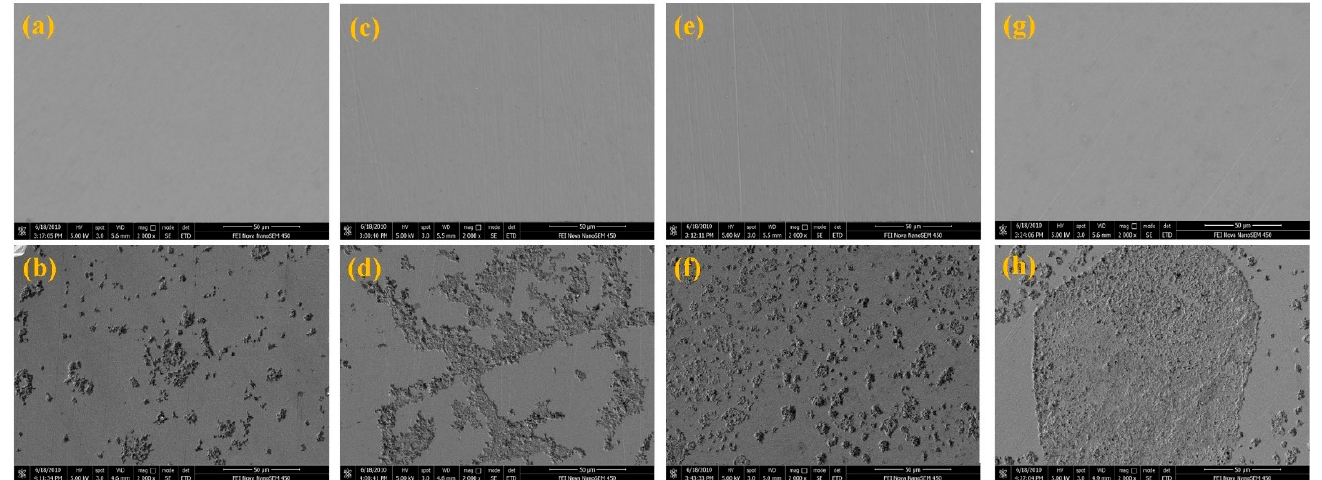
Figure 6. SEM morphologies of Cu electrodes before and after the electrochemical tests under different rolling reductions: ( a , b ) 0%, ( c , d ) 22.7%, ( e , f ) 58.6%, and ( g , h ) 77.3%.